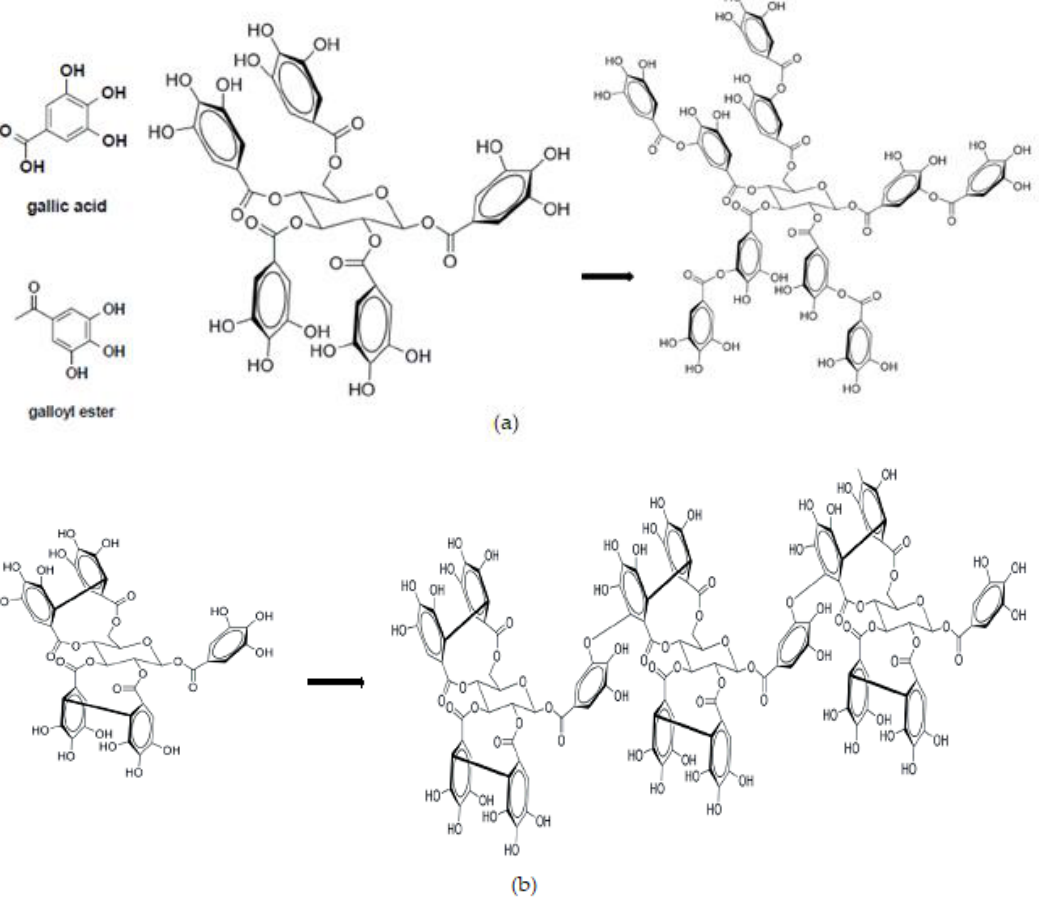
Figure 2. Subunits and interlinkage structures of gallotannin and ellagitannin in hydrolysable tannins, described as ( a ) β-1,2,3,4,5,6-pentagalloyl glucose forming gallotannin (tannic acid) and ( b ) casuarictin (ellagitannin) forming trimer of casuarictin (ellagitannin). Source [14,26].